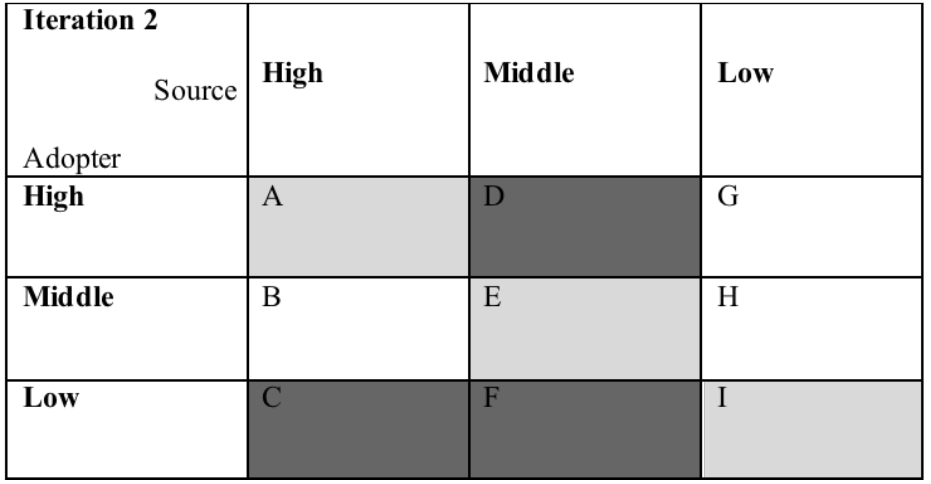
Fig. 3b. Iteration 2 Diffusion